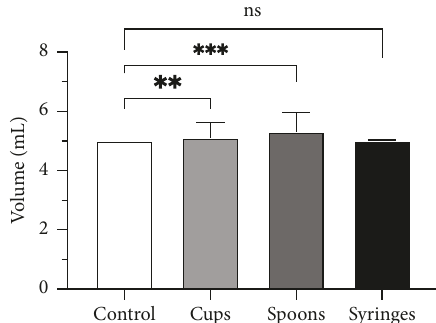
Figure 3: One-way ANOVA +post hoc Dunnett’s test of measured volume at the 5mL mark. Data are expressed as measured vol- ume ± standard deviation, n � 3. Statistically significant differences are marked with asterisks ((ns) p < 0 . 12; ( ∗∗ ) p < 0 . 002; ( ∗∗∗ ) p < 0 . 001).